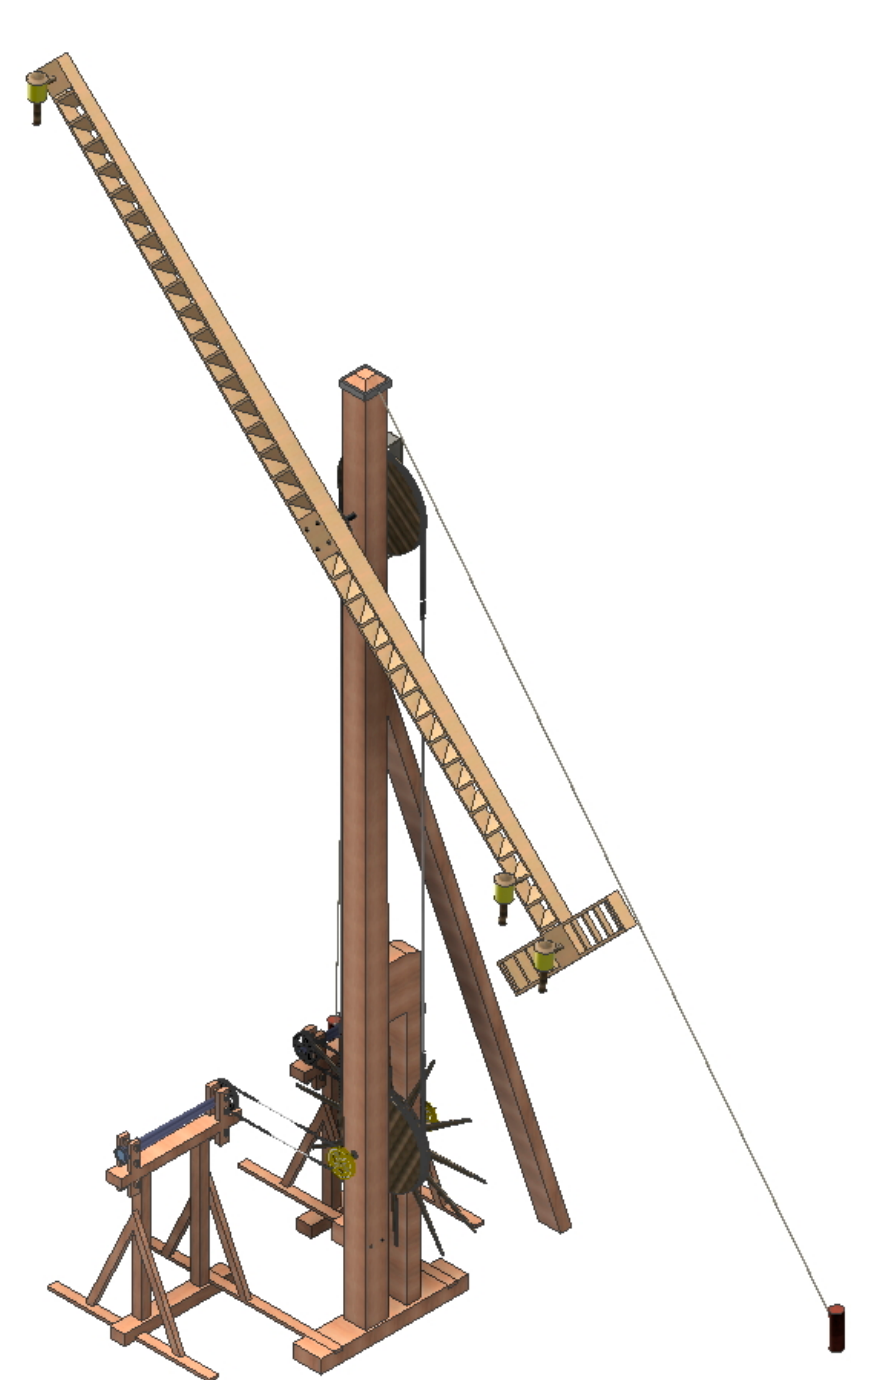
Figure 22. Optical telegraph assembled with all its elements.